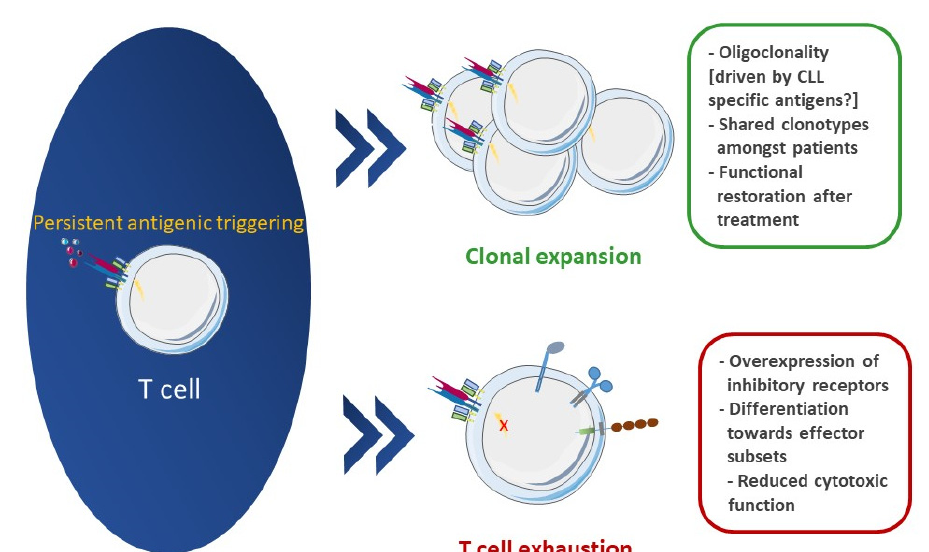
Figure 2. Chronic antigenic stimulation in CLL TME: functional and immunogenetic evidence. Persistent interactions with antigens lead T cells to functional exhaustion; however, clonal expansions as a response to these antigens occur in CLL patients.